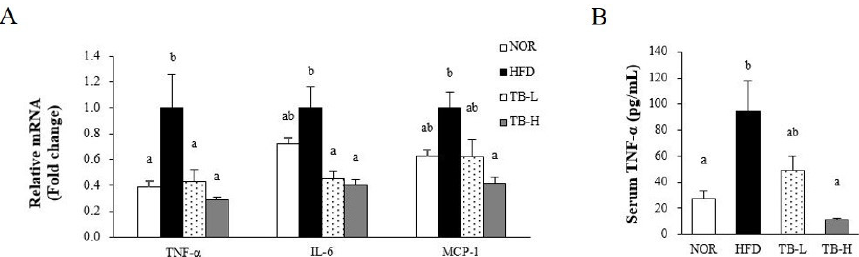
Figure 4. The effect of tartary buckwheat extract on pro-inflammatory cytokines. ( A ) mRNA level of pro-inflammatory factors TNF-α, IL-6, and MCP-1 in adipose tissue, and ( B ) serum TNF-α. The mRNA level was normalized to GAPDH. Data are expressed as mean ± SEM ( n = 8). Values with different letters are significantly different at p < 0.05. NOR: normal diet; HFD: 45% high-fat diet; TB-L: HFD + 0.5% TB; TB-H: HFD + 1.0% TB.